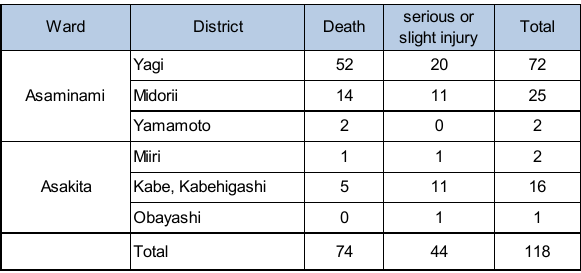
Figure 11. Result of taking rainfall information of the X-band MP radar into GIS (2014.08.20 4:00).